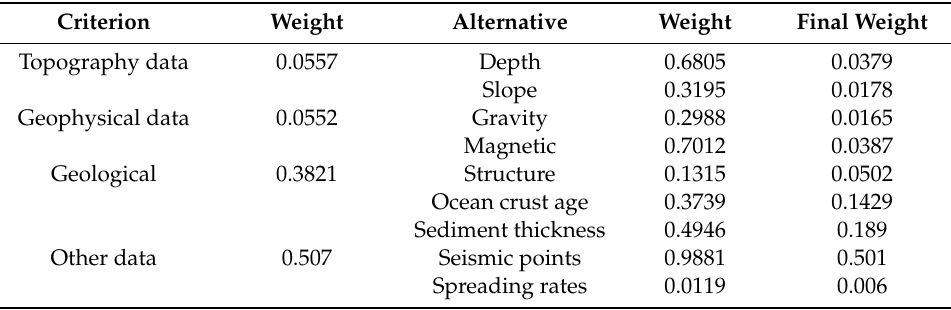
Table 6. Weights of criteria and